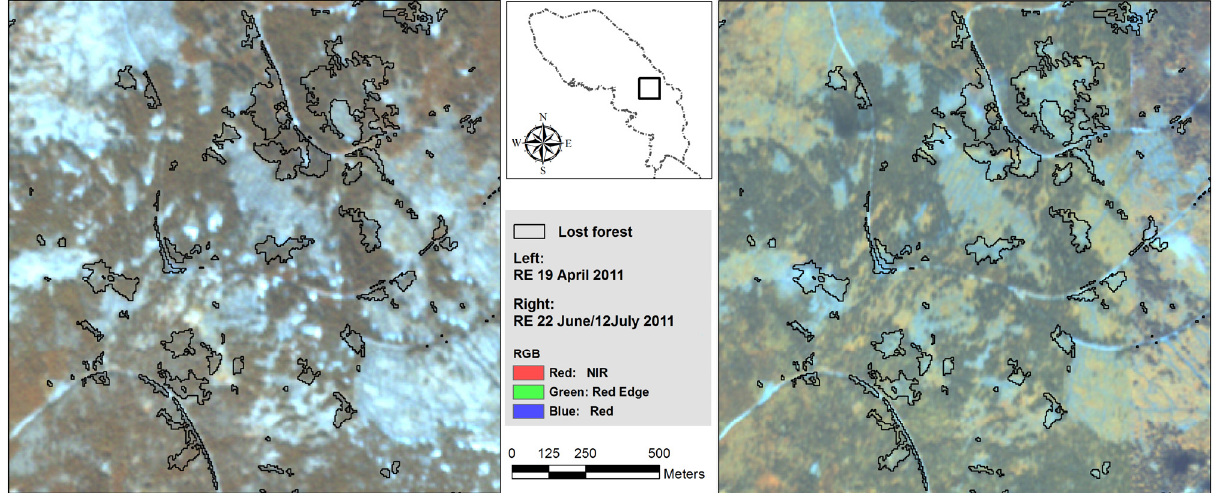
Figure 4. Example of some of the forest cover losses during the first period of analysis from 19 April to 22 June/12 July which were detected using RapidEye data.